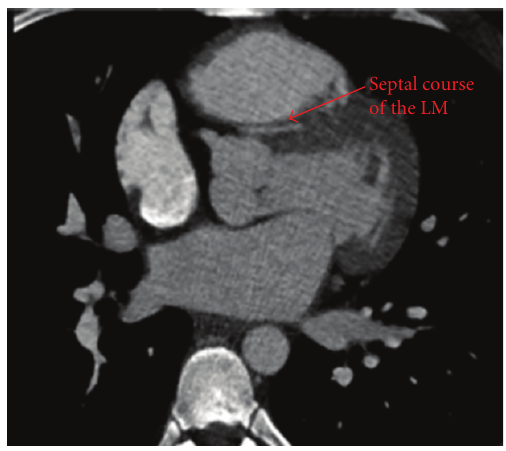
Figure 2: Coronary CT showing the left main (LM) traveling between the left ventricular outflow tract (LVOT) and the right ventricular outflow tract (RVOT).